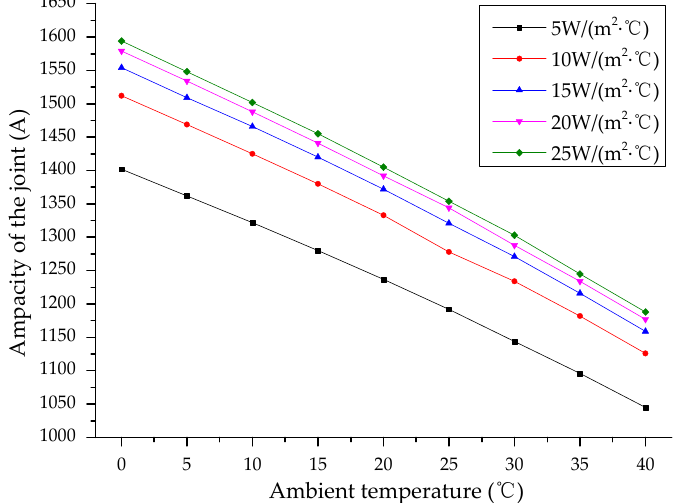
Figure 17. Cable joint ampacity under different ambient temperatures.